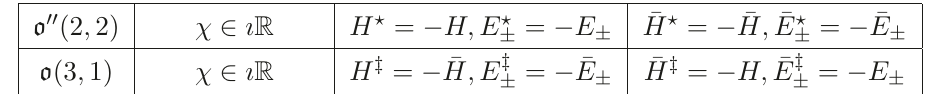
Table 2 . Real quantizations of r I ( χ ) = χ ( E + + ¯ E + ) ∧ ( H + ¯ H